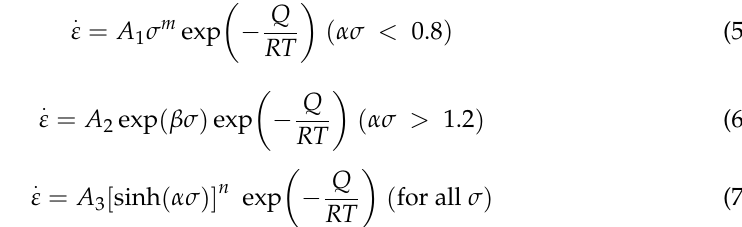
Figure 10. The relationship between the peak stress, strain rate and deformation temperature in the second layer of the deposited alloy: ( a ) ln ε ˙ ‐ ln σ s , ( b ) ln ε ˙ ‐ σ s , ( c ) ln ε ˙ ‐ ln[sinh( ασ )], ( d ) ln[sinh( ασ )] ‐ 1/T.